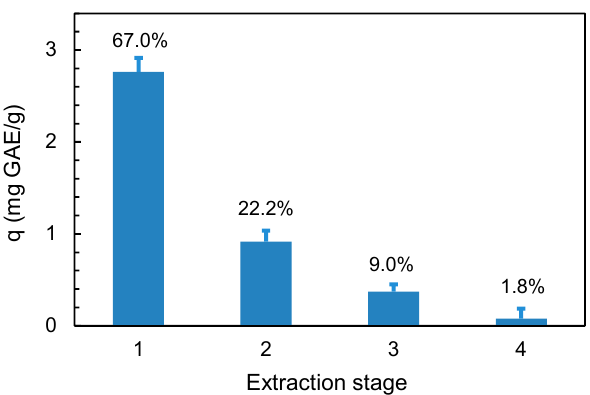
Figure 1. Amount of recovered phenolic compounds per unit weight of dry solid (q) in each extraction stage, with the associated recovery percentages. Table 1. Concentration of phenolic compounds (c) and antioxidant activity (AA) of water–organic solvent extracts from brewers’ spent grain (BSG). Data are expressed as mean ± standard deviation ( n = 3).